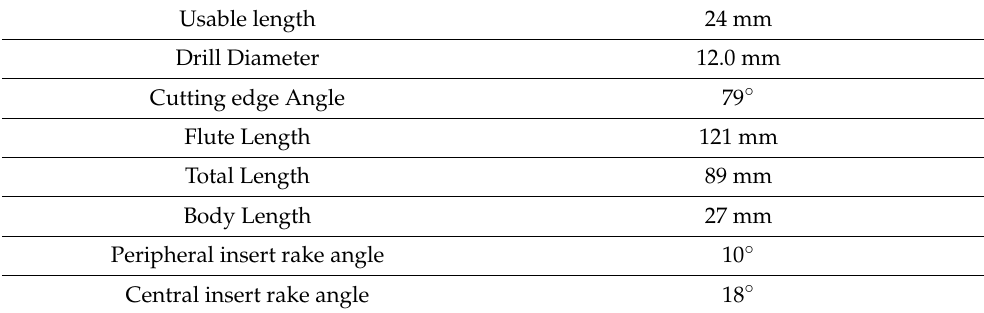
Table 2. Details of the Coro Drill 880 drills employed for Inconel 718.